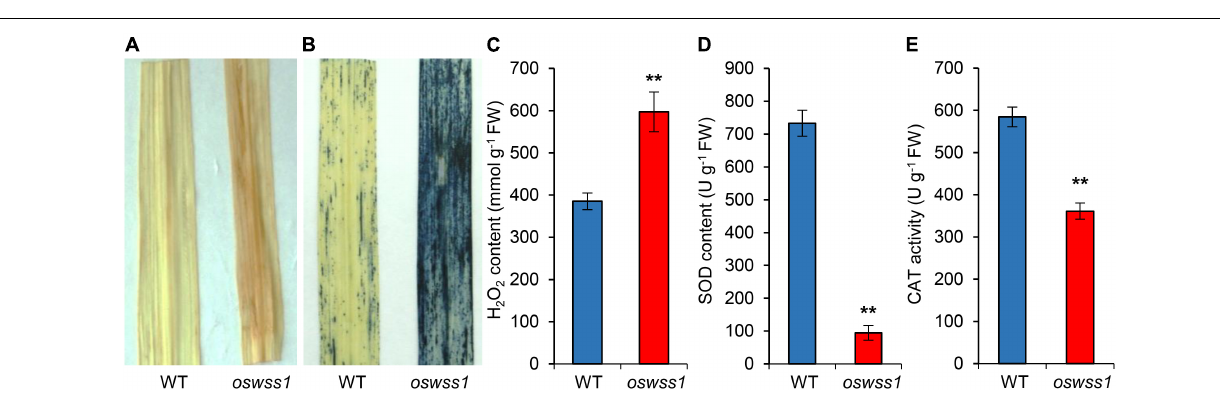
FIGURE 8 | Reactive oxygen species is highly accumulated in the oswss1 leaves at the tillering stage (87 DAS). (A) 3,3 (cid:48) -diaminobenzidine (DAB) staining of leaves between wild type (WT) and oswss1 plants. (B) The nitroblue tetrazolium (NBT) staining of leaves between WT and oswss1 plants. (C–E) Quantification of H 2 O